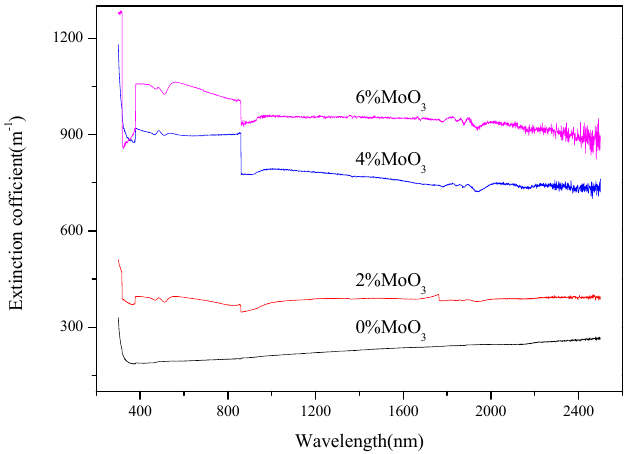
Figure 4. The calculated extinction coefficients of samples with various MoO 3 contents.